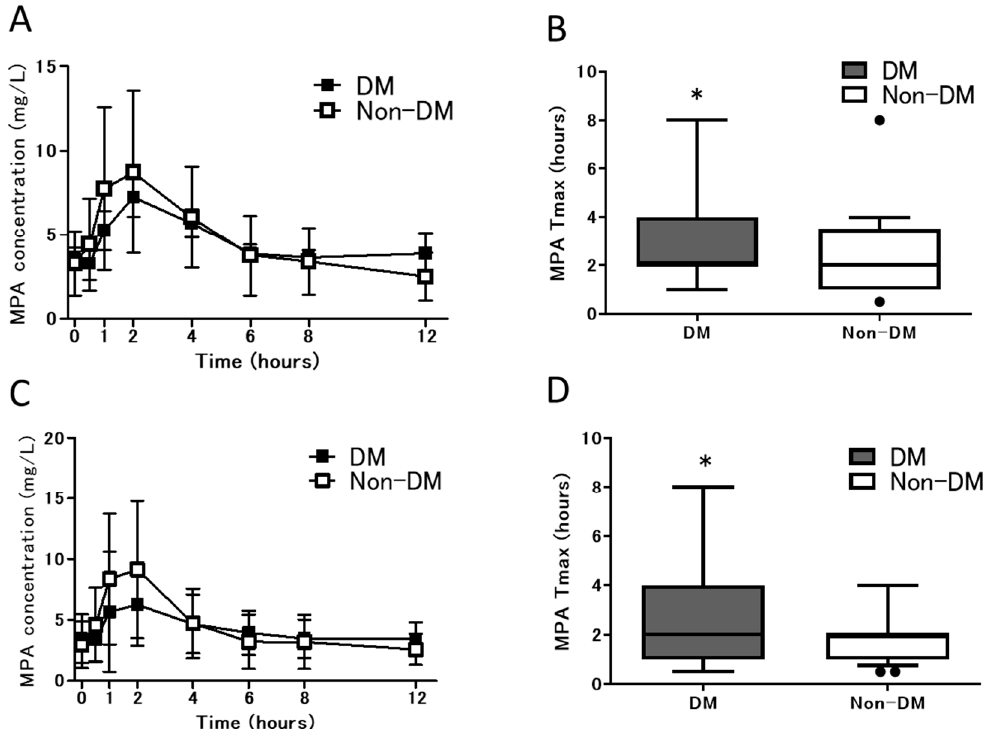
Figure 1. MPA pharmacokinetics at 3 weeks and 3 months in the DM and Non-DM groups. ( A ) Mean concentration–time profile of MPA at 3 weeks, ( B ) Tmax of MPA at 3 weeks, ( C ) mean concentration–time profile of MPA at 3 months, and ( D ) Tmax of MPA at 3 months. Abbreviations: MPA, mycophenolic acid; Tmax, time to maximum concentration; DM, patients with diabetes; and non-DM, patients without diabetes.